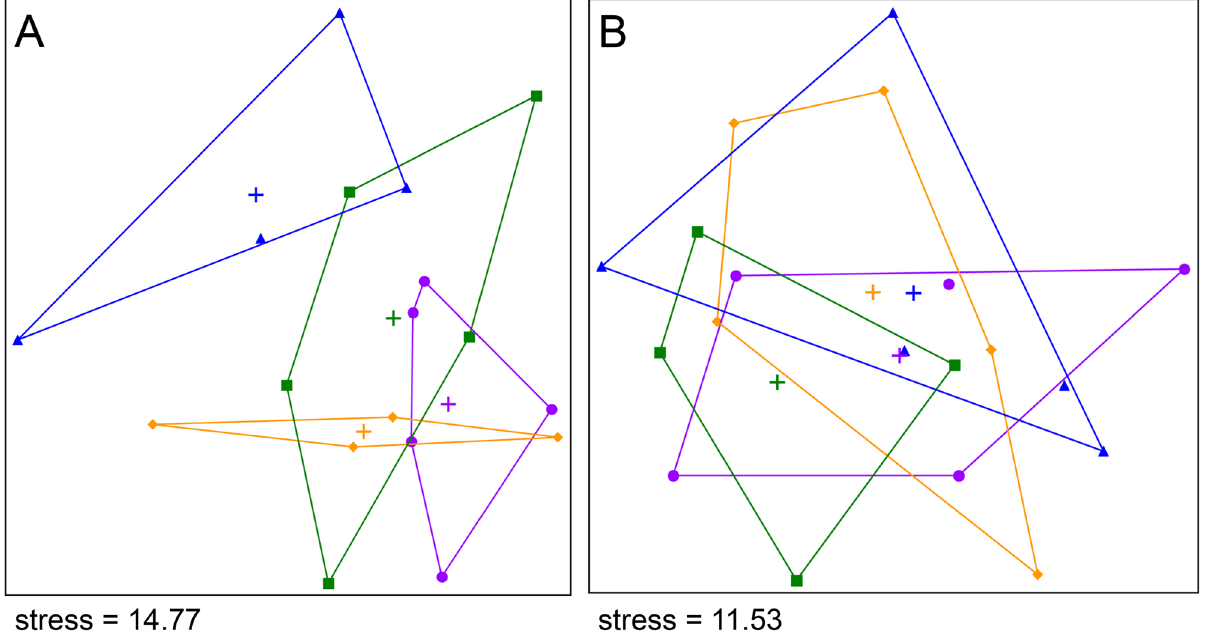
Fig 1. Non-metric multidimensional scaling (NMS) ordination plots. (A) 7,4 0 -Dihydroxyflavone experiment, (B) naringenin experiment. Points represent samples, crosses are group centroids. Samples of the same treatment are enclosed in convex hulls. Stress is calculated on a scale of 0 to 100. (Treatments: ● high, ♦ medium, & low, and ▲